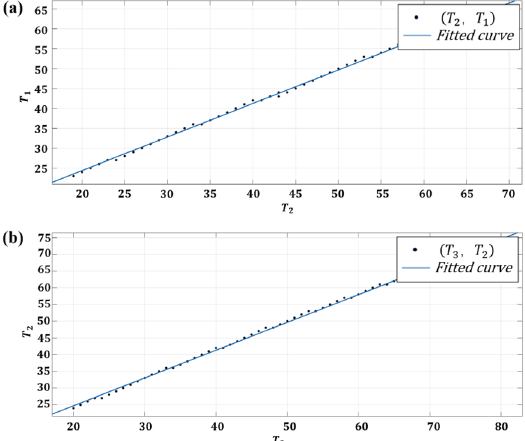
Figure 11. Optimal combination between T 1 and T 2 and T 2 and T 3 . ( a ) Curve fitting between T 1 and T 2 . ( b ) Curve fitting between T 2 and T 3 .